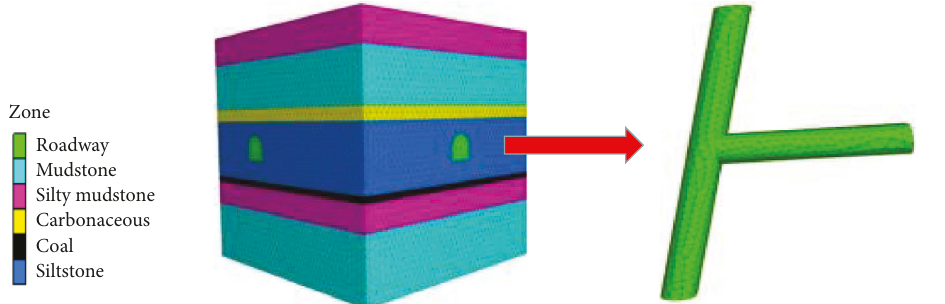
Figure 4: Numerical simulation model.